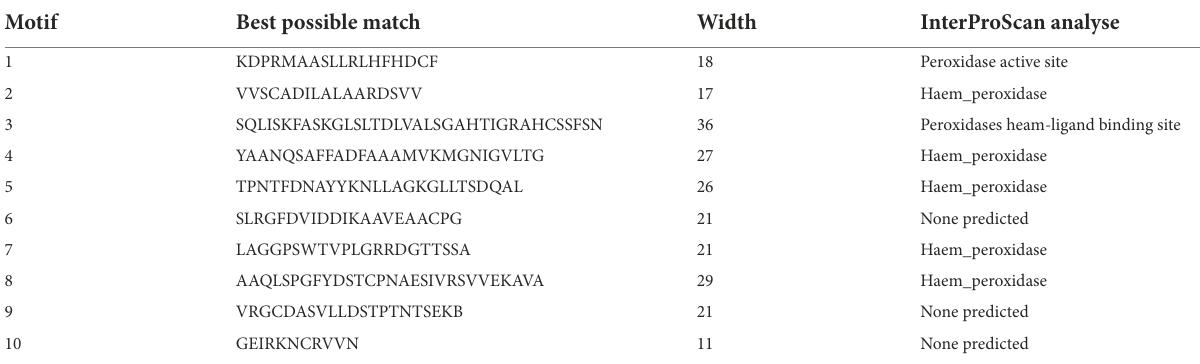
TABLE 2 List of the identified motifs in AcPRX